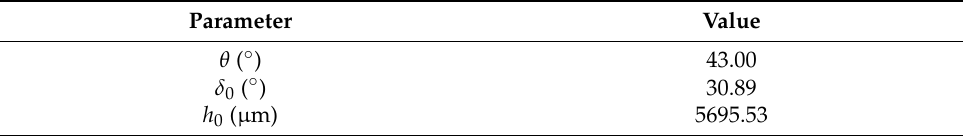
Table 4. Fixed parameters in the system.